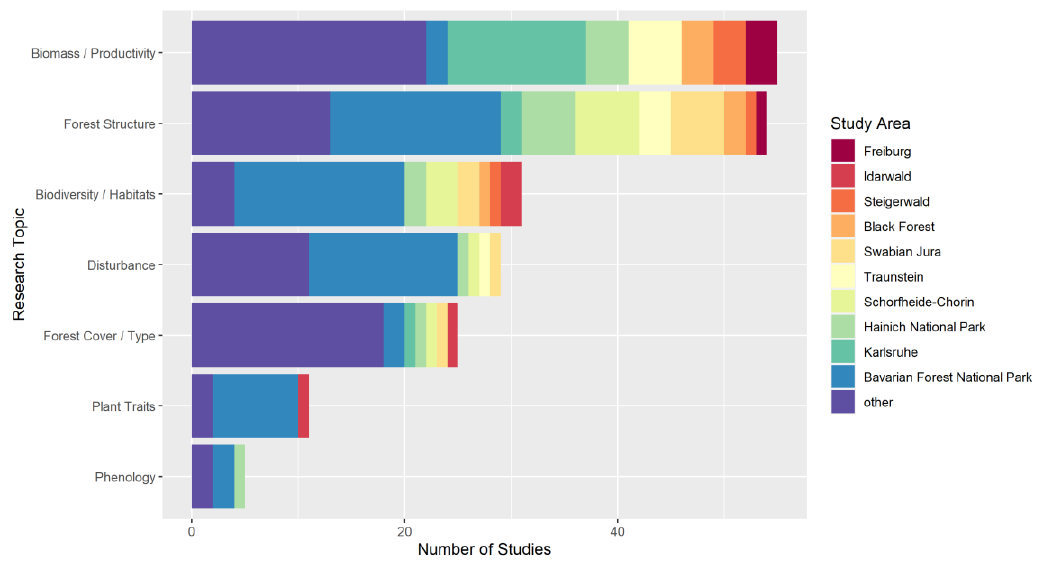
Figure 17. Research topics by study areas. Note that the order of the mentioned topics has